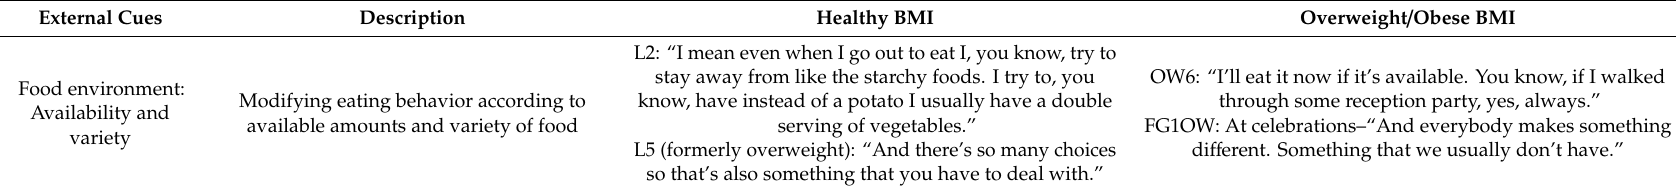
Table 3. Categories of external cues that influence eating